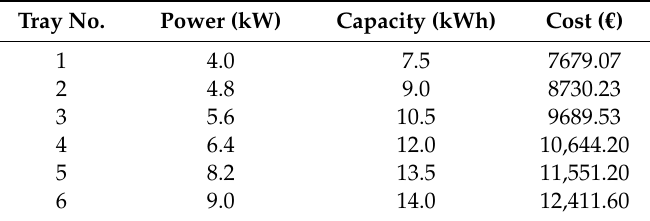
Table 1. Technical parameters and the cost of ESU used in the analysis of LV grids. Tray